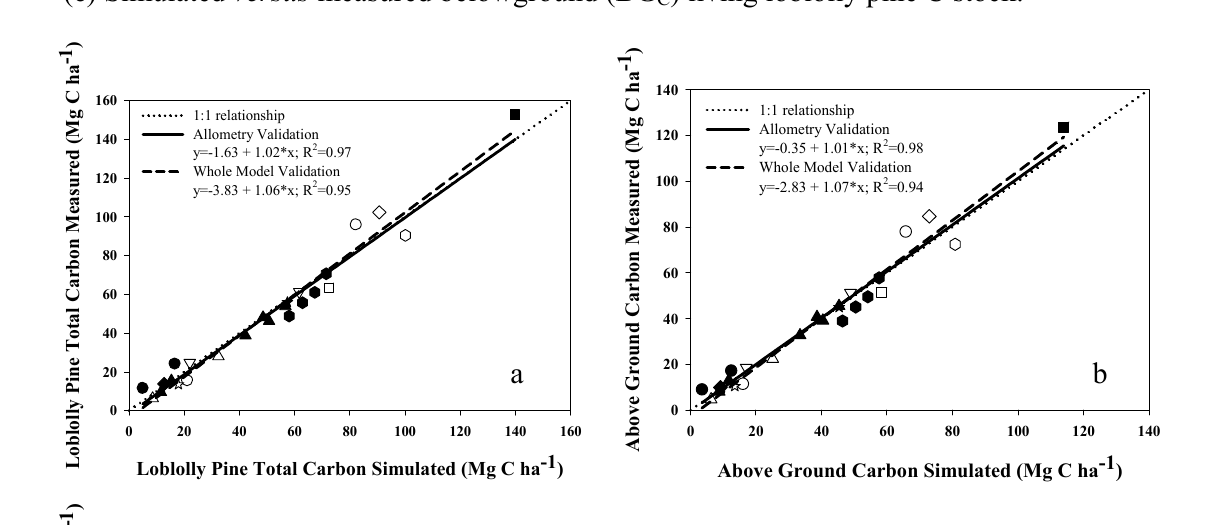
) in living loblolly pine; C ) living loblolly pine C stock; C ) living loblolly pine C C